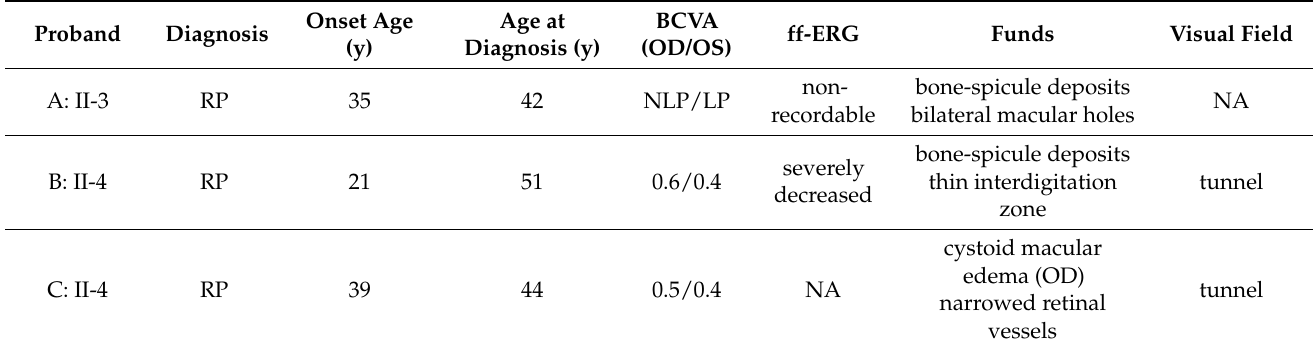
Table 1. Clinical characteristics of the probands.